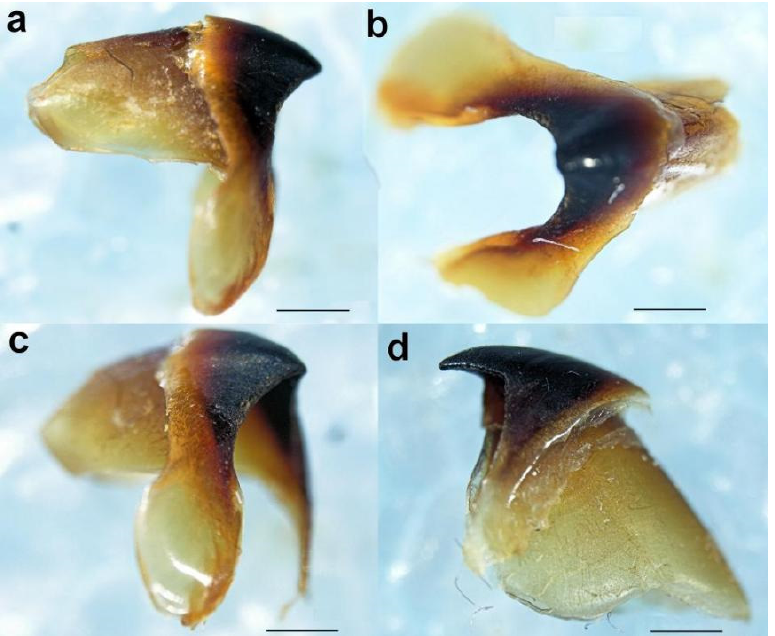
Figure 18. Beaks of Sepia typica : Lower beak of SAIAB 211629, female ML 18 mm in profile ( a ), top ( b ) and oblique ( c ) aspects; (d) Upper beak of SAIAB 211661, male ML 22 mm in profile; Scale bars 1000 μ m.